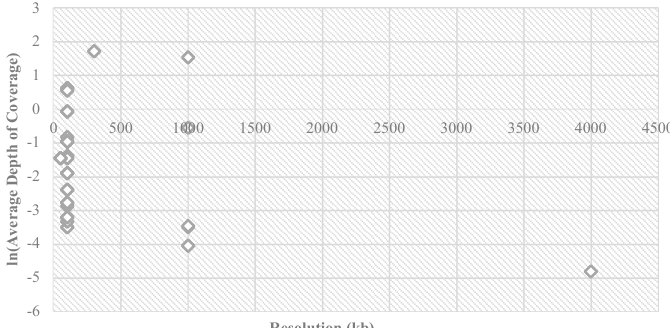
Figure 4. Sequencing parameters used by 21 Chinese tertiary hospitals in this survey. The average depth of coverage (ln value) varied across different reported detection limits for CNV size detection (resolution). Taking the resolution of 100 kb as an example, the average depth of coverage ranged from 0.03 (ln − 3.5 in the figure) to 1.88 (ln0.6 in the figure).